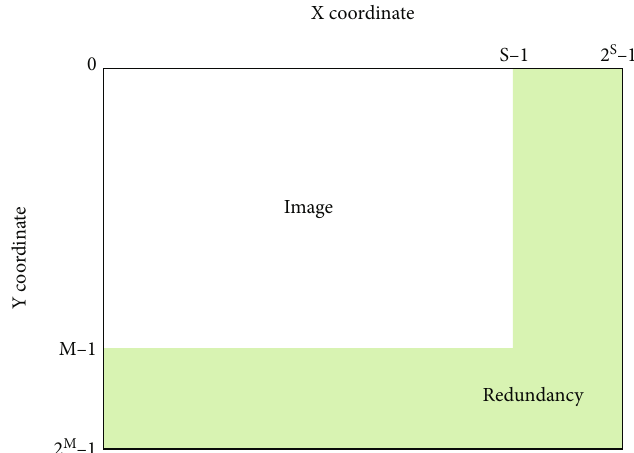
Figure 2: E ff ective ceramic color pixel and redundant ceramic color pixel map obtained by model processing.